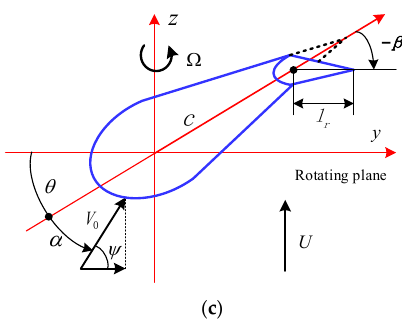
Figure 1. The circumferentially asymmetric stiffness (CAS) ‐ based blade system with the rigid trailing ‐ edged flap: ( a ) The CAS ‐ based blade system with the trailing ‐ edged flap; ( b ) The actual cross ‐ section at position l 1 ; ( c ) The equivalent cross ‐ section with parameters in position l 1 .